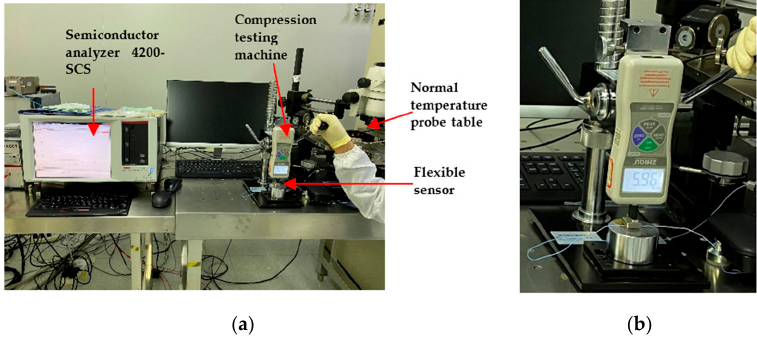
Figure 7. ( a ) The physical test diagram of flexible pressure sensor; ( b ) pressure testing machine ZQ-32.